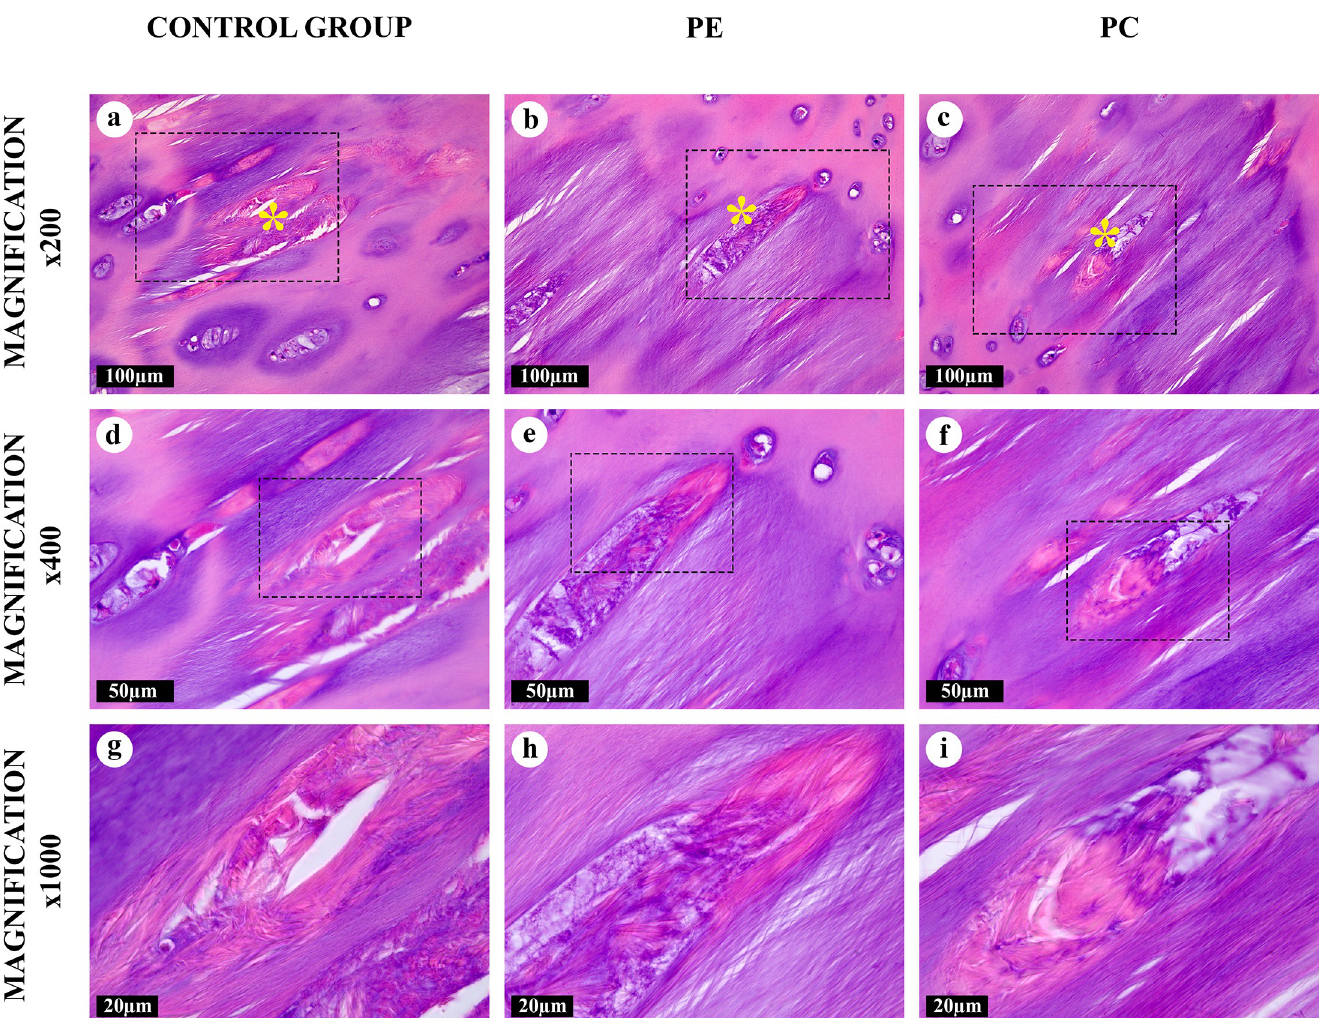
Fig 4. “Intralacunary” amianthoid transformation areas in the costal cartilages, hematoxylin and eosin. Some degenerating lacunae formed lens-shaped cavities containing AFs ( � ). The AFs were eosinophilic and oriented chaotically.